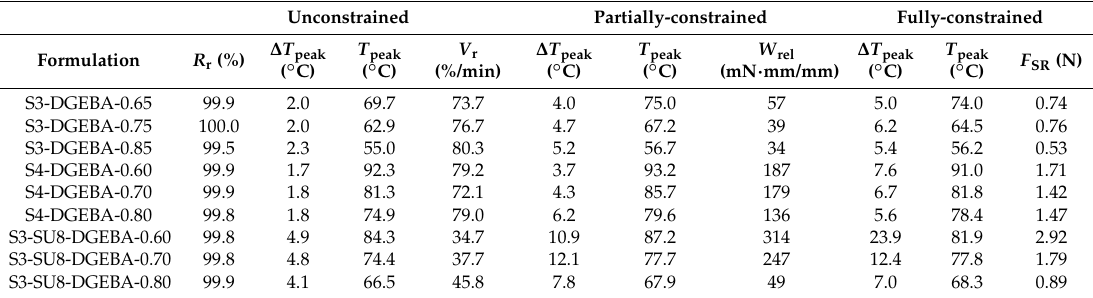
Table 4. Parameters obtained from the shape-memory analysis (unconstrained, partially-constrained and fully-constrained) of the different formulations studied: Peak temperature ( T peak ), Width at half-height of the peak ( ∆ T peak ), Recovery-rate ( R r ), Relative Work output ( W rel ) and shape-recovery force ( F SR ). Unconstrained Partially-constrained Fully-constrained ∆ T peak Formulation R r (%) ( ◦